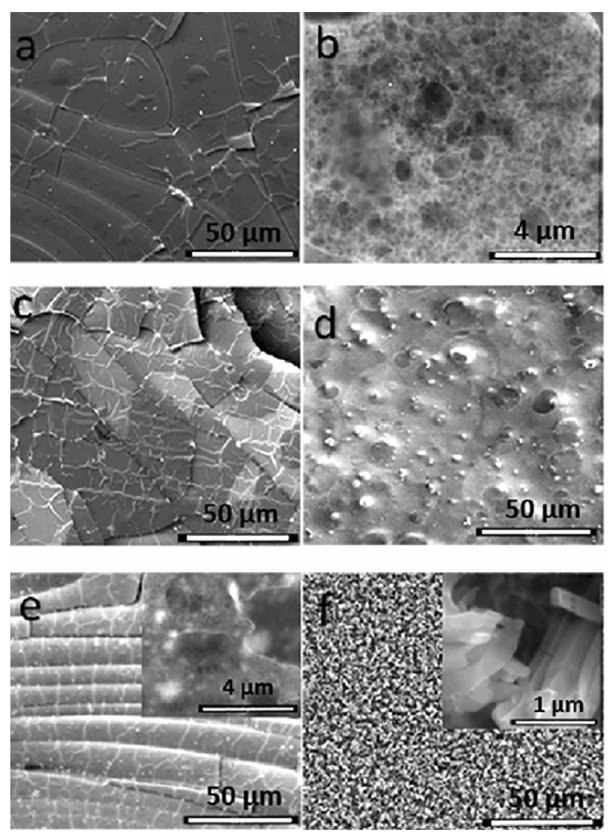
Fig. 5 SEM Images of pure chitosan and the bi-composite Ch/Col and Ch/HA membranes a , b Chitosan (Cs). c BC1. d BC2. e BC3. f BC4; insets are magni fi ed regions of the